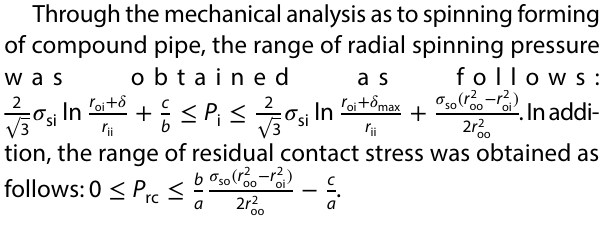
Fig. 5 The comparison of residual contact pressure